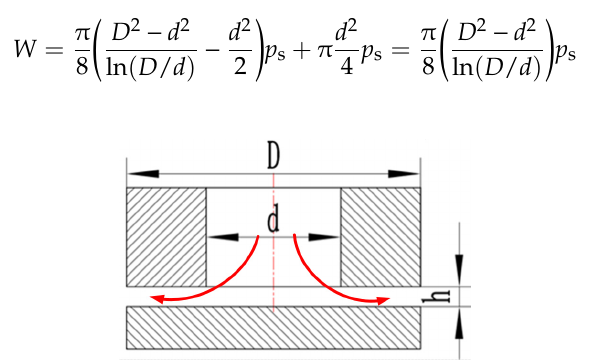
Figure 15. The schematic of 316L- PTFE friction pair (parallel disk damper).